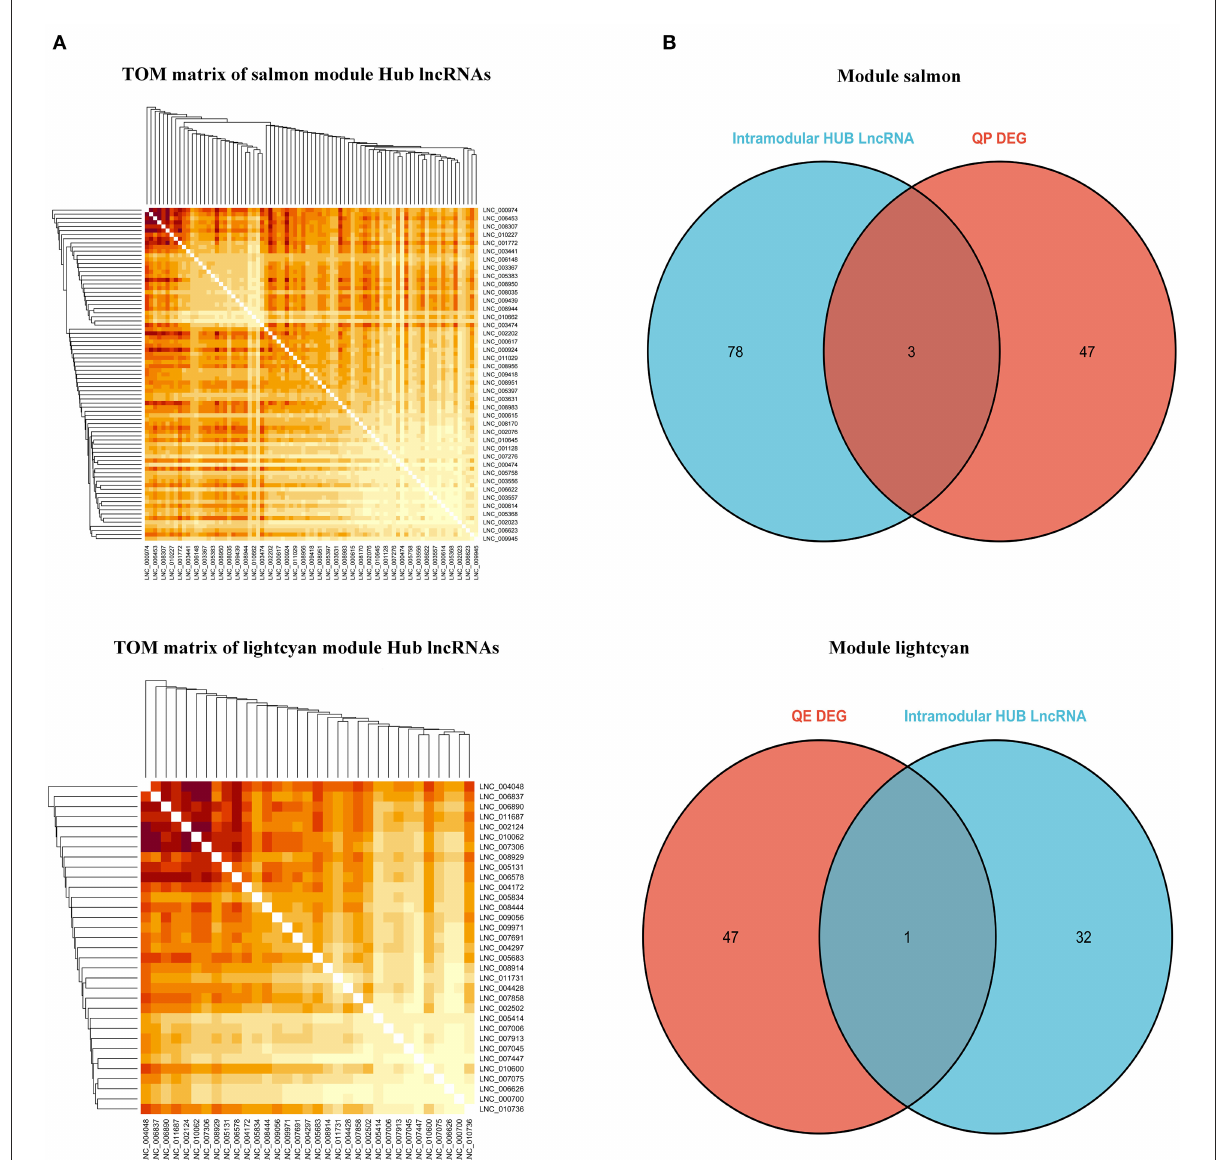
FIGURE11 Identification of hub LncRNAs. (A) TOM matrix between candidate LncRNAs. (B) Wayne diagram of overlapped genes between LncRNAs and intra-module hub genes.